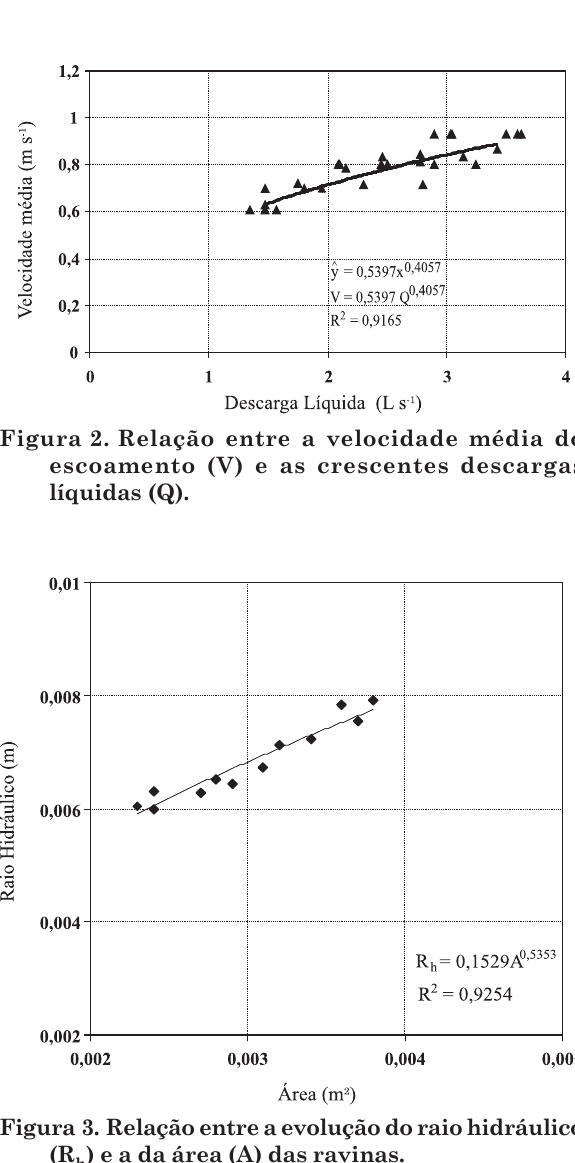
Figura 3. Relação entre a evolução do raio hidráulico (R ) e a da área (A) das h